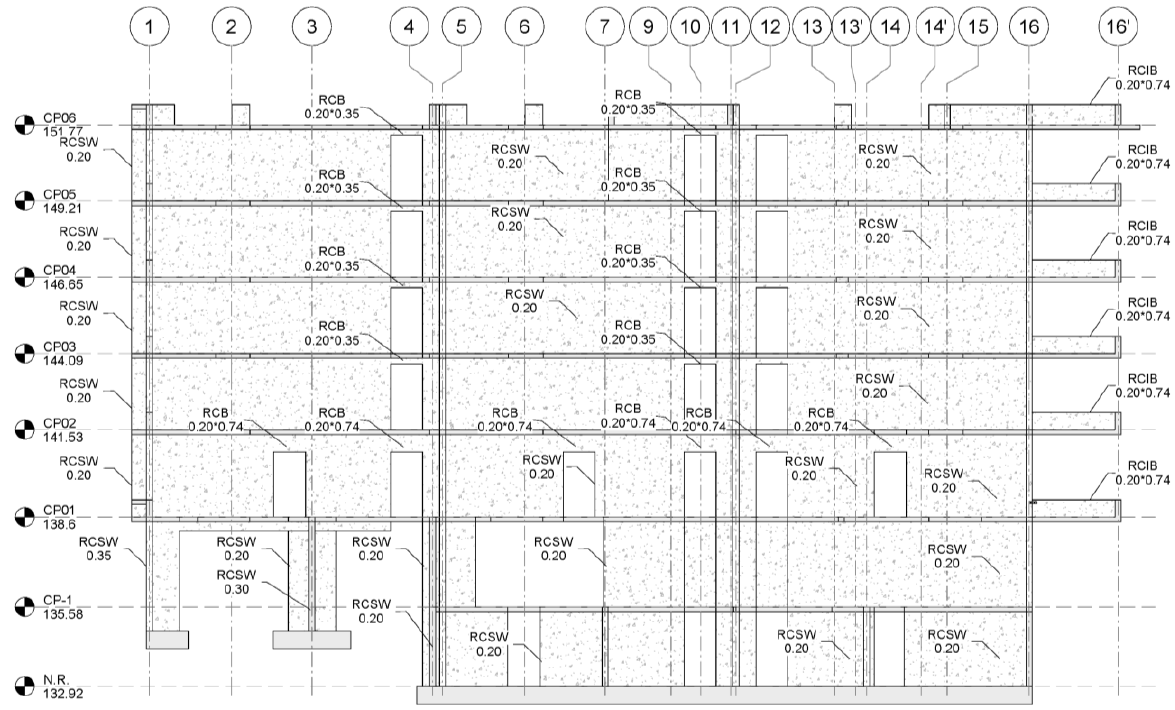
Figure 2. Typical plan view of the building, with the shear walls marked in blue and the beams in green.